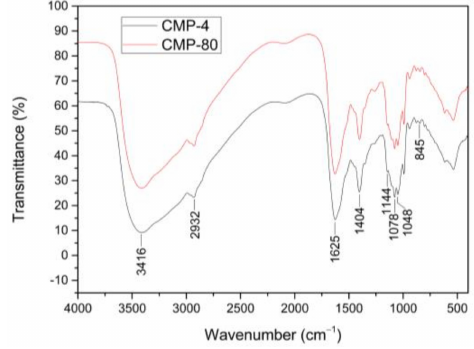
Figure 2. The IR spectras of CMPs-4 and